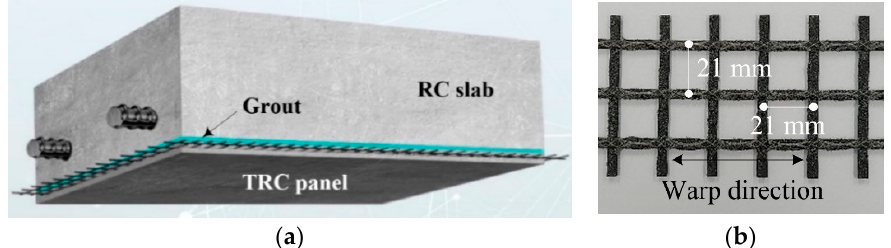
Figure 2. ( a ) Schematics of strengthening of concrete element with TRC panel and grout; and ( b ) carbon textile grid (Anticrack Q85/85-CCE-21-E4, Solidian-Kelteks Co. Ltd. Karlovac, Croatia).